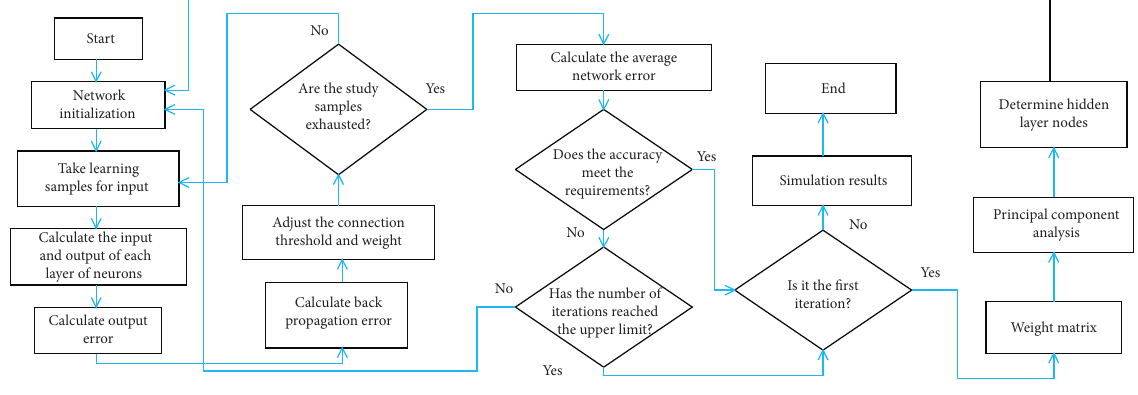
Figure 4: Improved BP algorithm